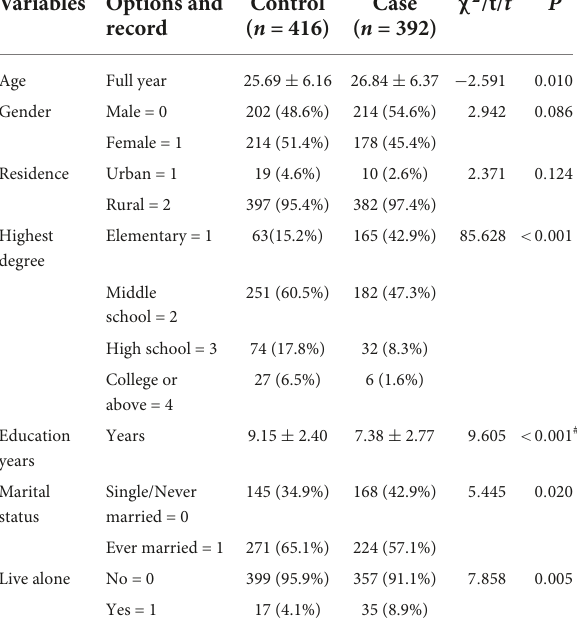
TABLE 2 Predictors of suicide in case and control